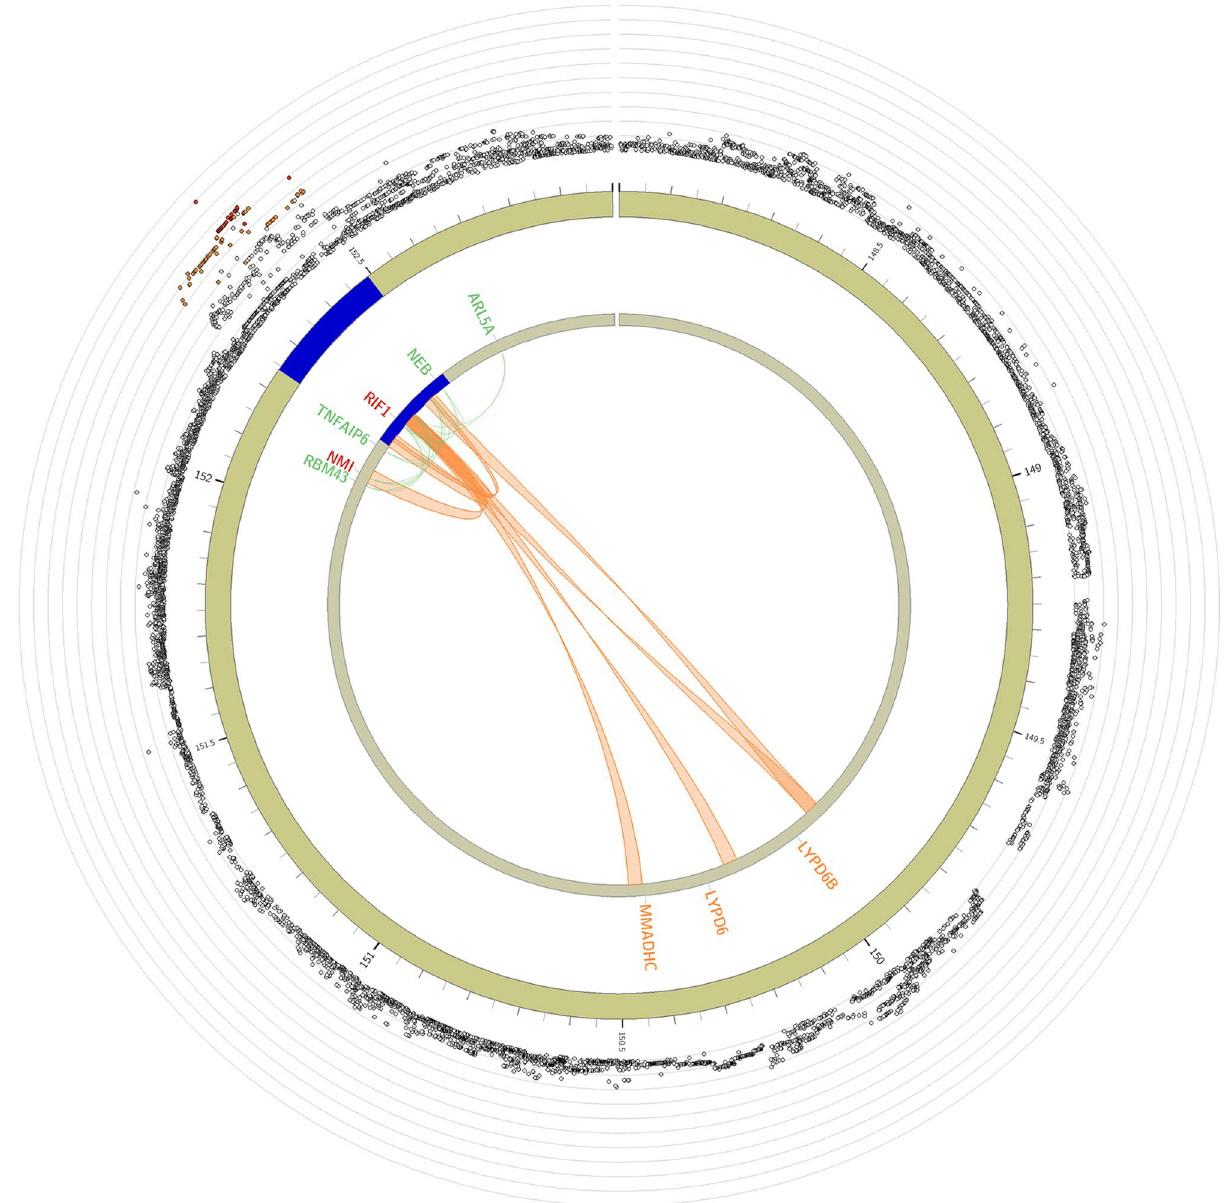
Figure 2. Cross-locus interactions for genomic regions associated with SMI. Circos plot showing genomic risk loci on genes on chromosome 2 implicated by eQTL (green), chromatin interaction (CI; orange), or implicated by both eQTL and CI mapping (red). The outer layer shows a Manhattan plot containing the -log10-transformed p-value of each SNP in the GWAS. The circos plot was generated using FUMA v1.3.6 (https ://fuma.ctgla